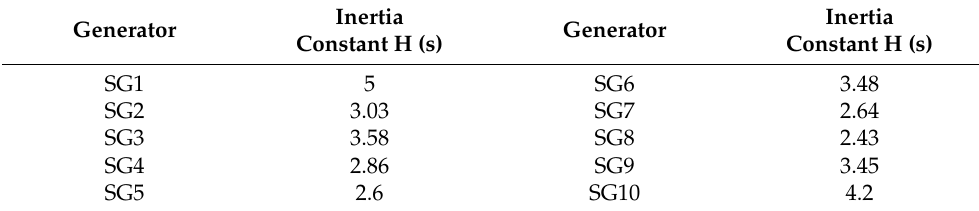
Table 1. The IEEE 39-bus System Synchronous Generators Inertia